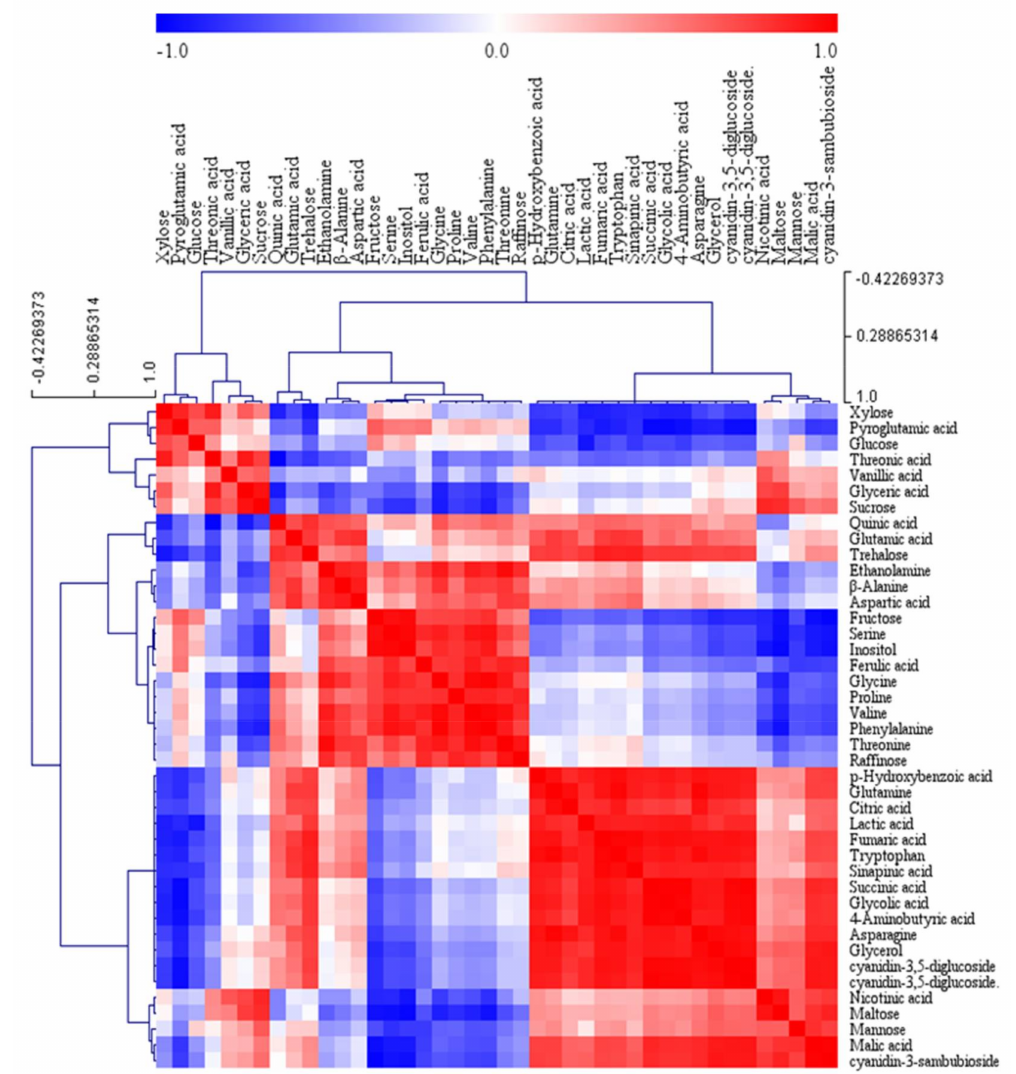
Figure 4. Correlation matrix of 42 metabolites from three different colored flowers of R . schlippenbachii . Each square indicates the Pearson correlation coefficient of a pair of compounds. The value of correlation coefficient is represented based on the intensity of the red and blue colors. Secondary metabolites were marked by a yellow